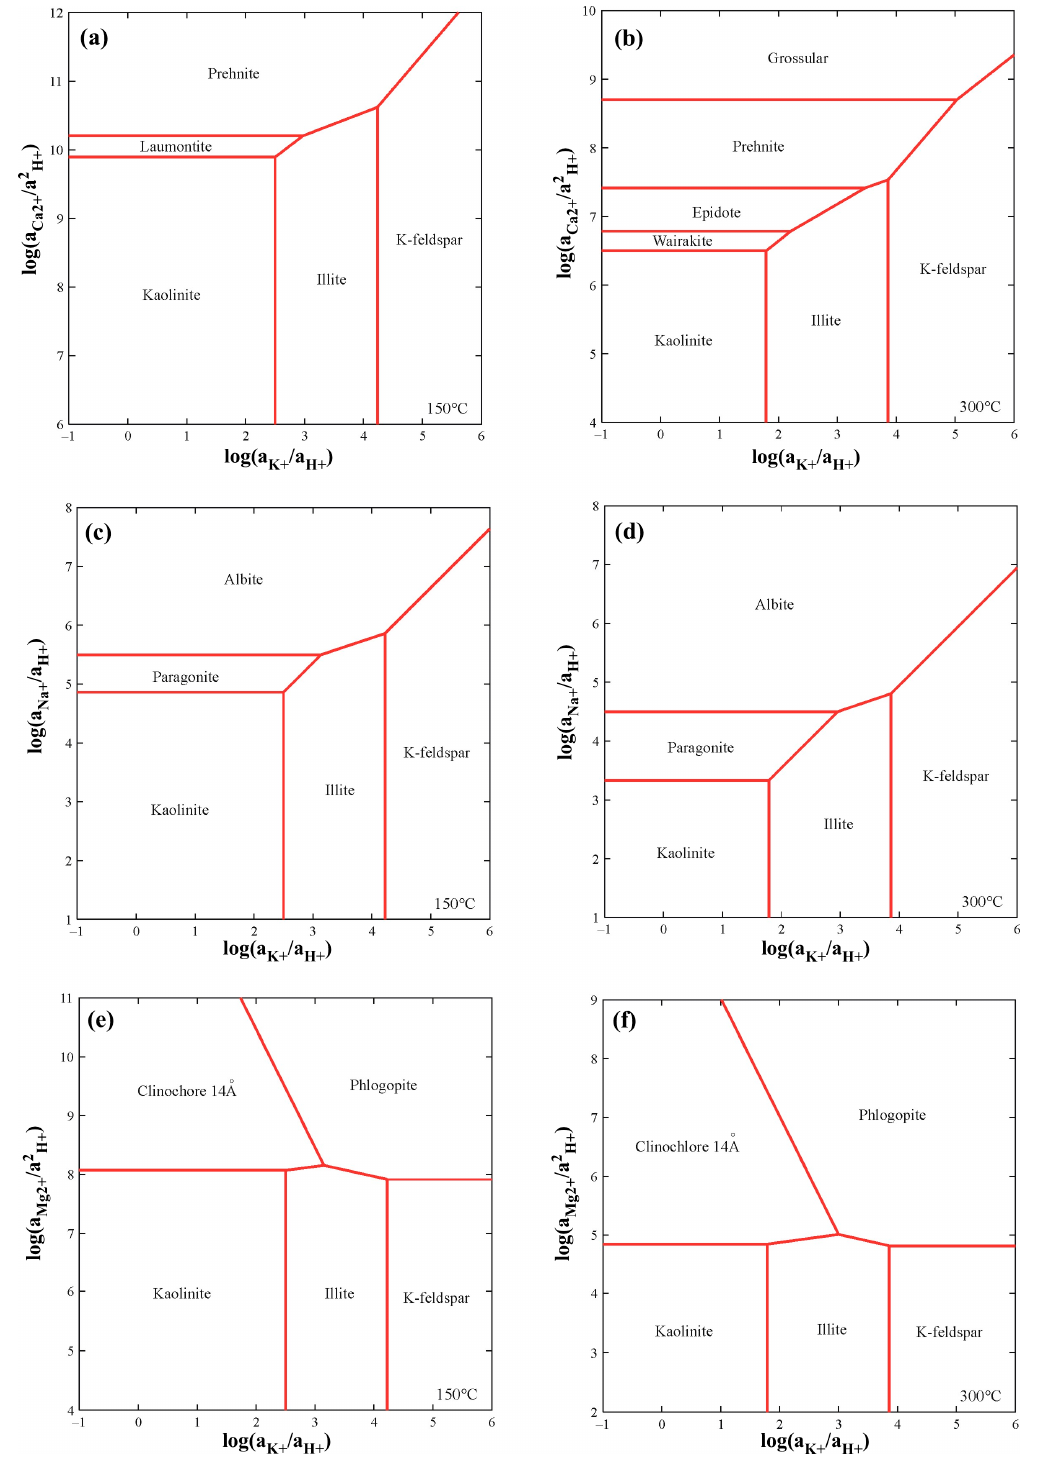
Figure 1. Stability diagrams as a function of cation activity ratios at constant temperature: ( a ) the system K 2 O-CaO-Al 2 O 3 -SiO 2 -H 2 O at 150 °C, ( b ) the same system at 300 °C, ( c ) the system K 2 O-Na 2 O-CaO-Al 2 O 3 -SiO 2 -H 2 O at 150 °C, ( d ) the same system at 300 °C, ( e ) the system K 2 O-MgO-Al 2 O 3 -SiO 2 -H 2 O at 150 °C, and ( f ) the same system at 300 °C. The diagrams were generated with the Act2 application of the Geochemist ‘s Workbench. For thermodynamic data of minerals, see Bethke [34] and references therein.